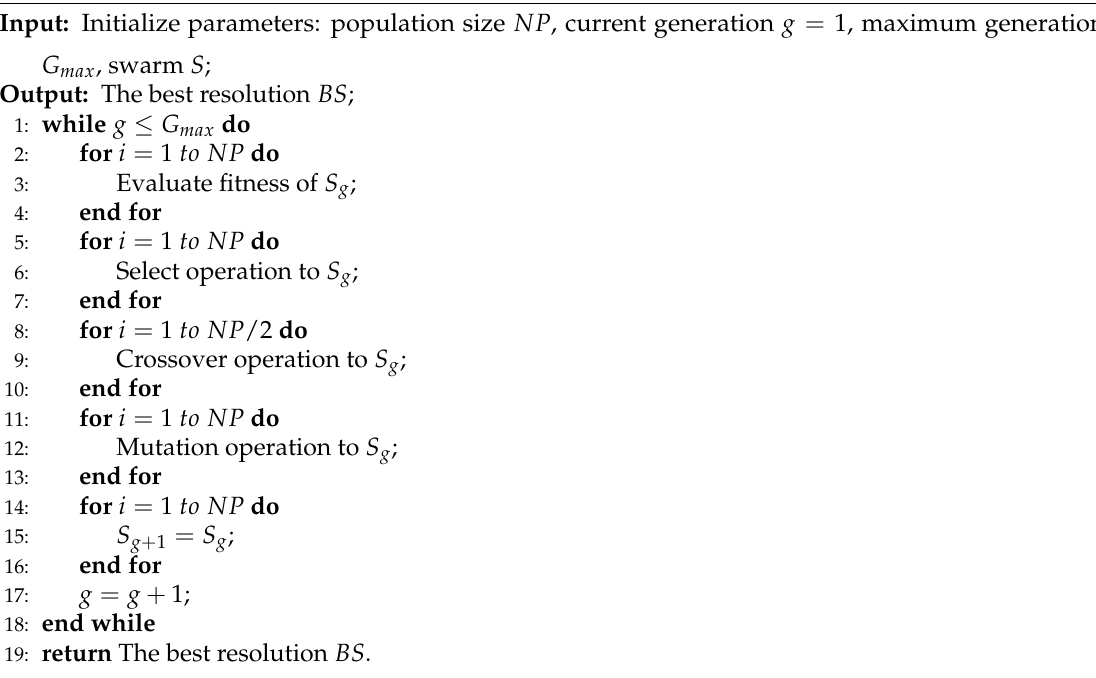
Algorithm 1 The GA